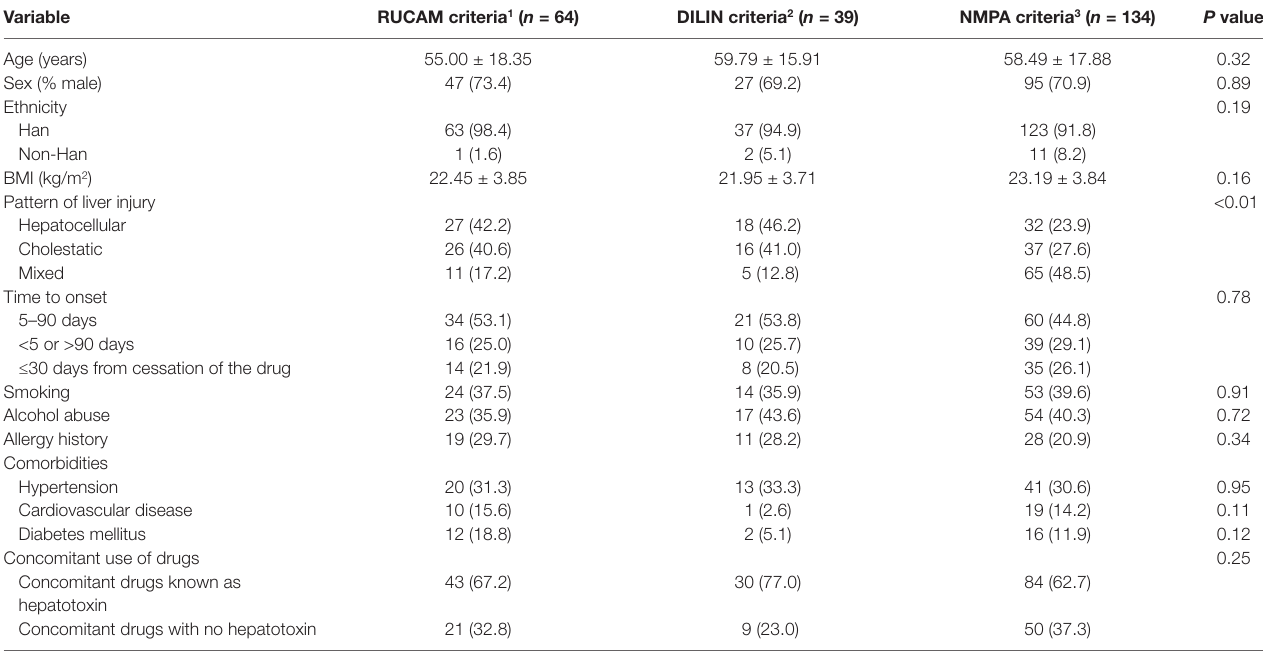
TABLE 2 | Demographic and clinical characteristics of three groups of positive cases.